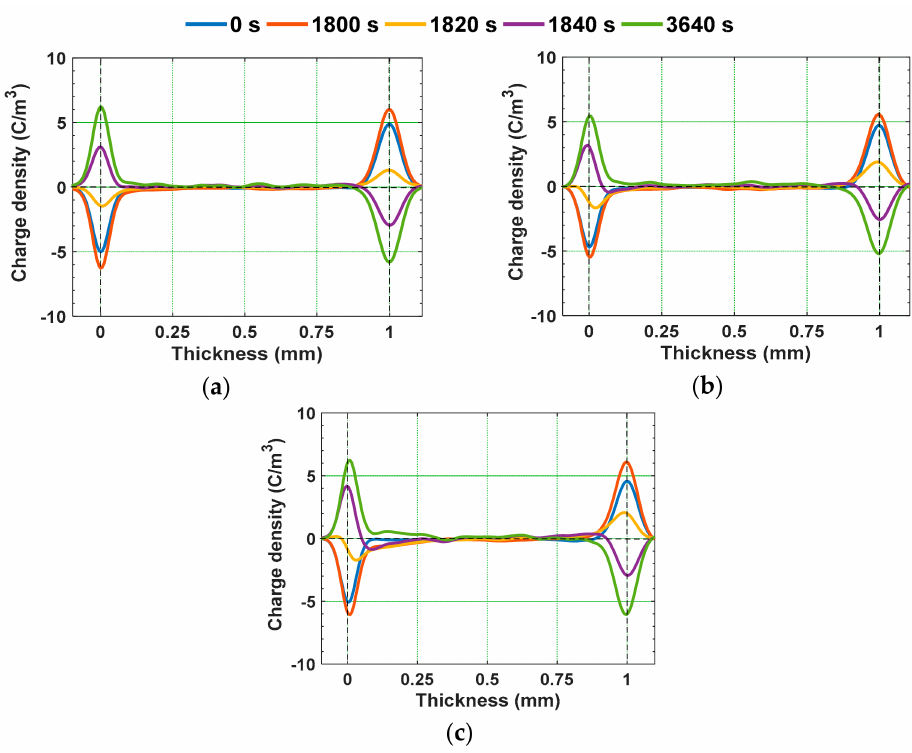
Figure 18. Space charge characteristics under voltage polarity reversal in ( a ) unaged specimen, ( b ) water aged specimen at RT, and ( c ) water aged specimen at 90 ◦ C